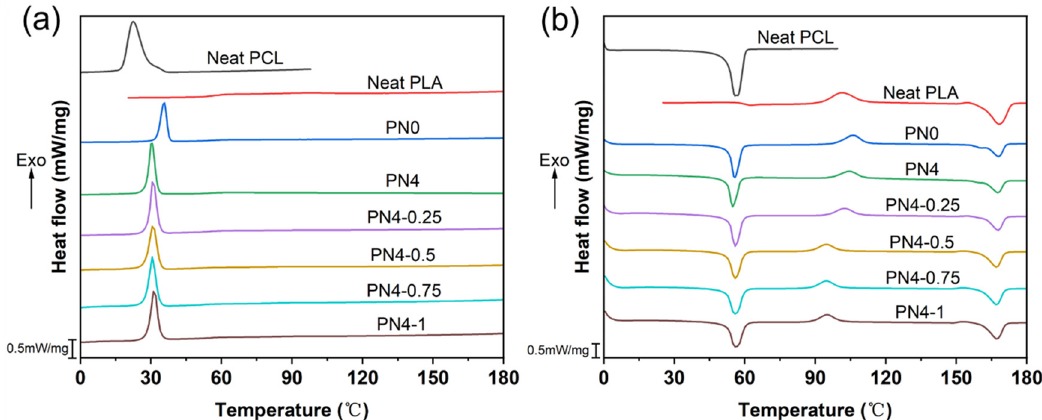
Figure 6. DSC curves measured for the PLA/PCL nanocomposites: ( a ) the cooling scans, ( b ) the second heating scans.